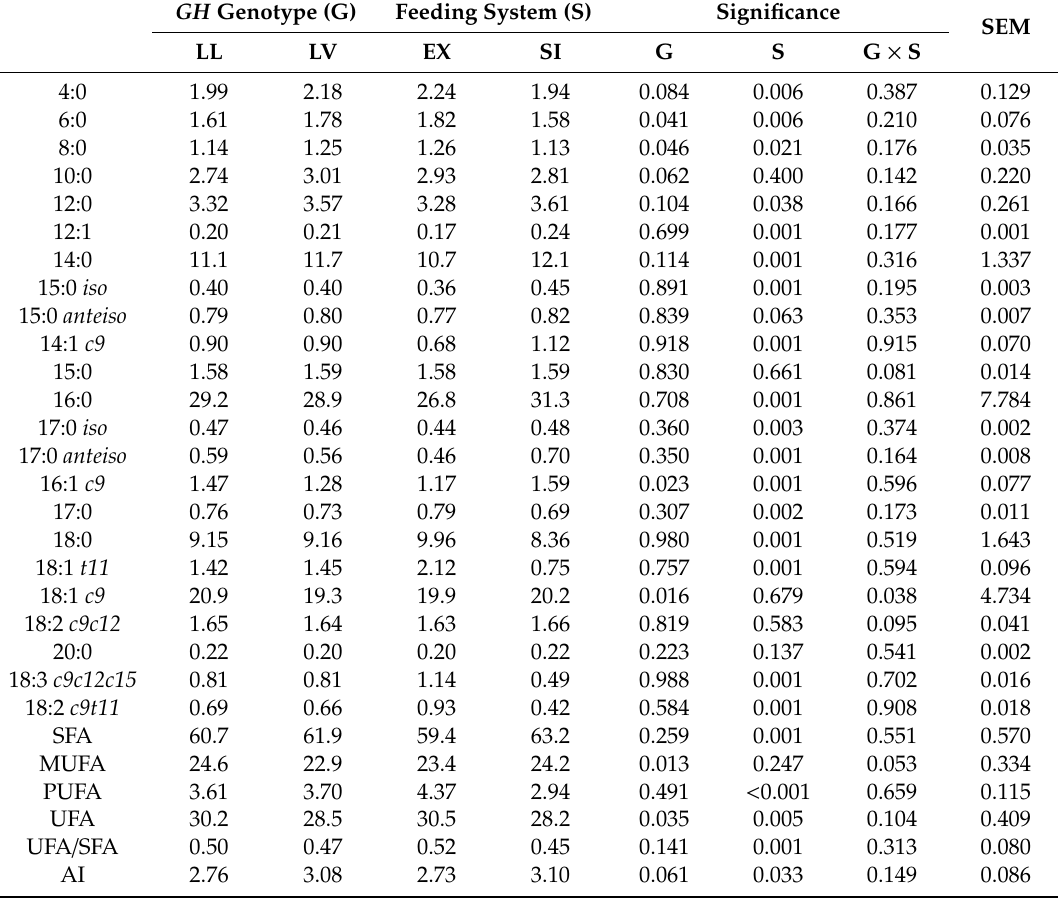
Table 3. E ff ects of GH p.L127V genotype and feeding system on milk fatty acid composition. GH Genotype (G) Feeding System (S)